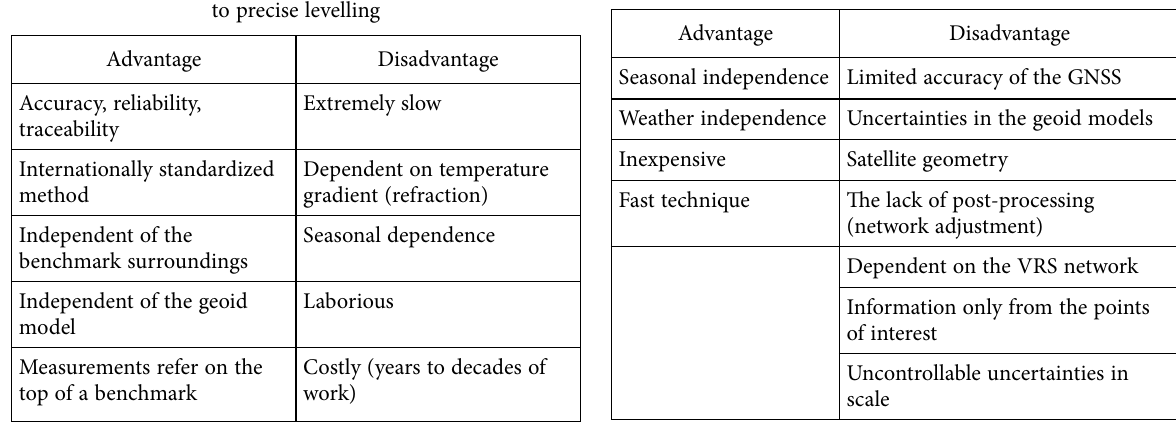
Table 3. Advantages and disadvantages related to VRS